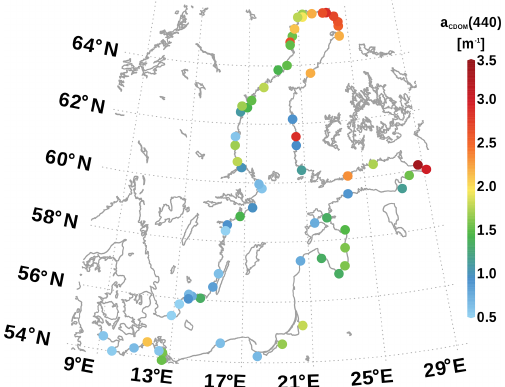
Figure 4. Mean a CDOM of the individual rivers used in the model. The map was created using the software package GrADS 2.1.1.b0 (http://cola.gmu.edu/grads/, last access: 6 August 2021), using pub- lished bathymetry data (Seifert et al.,